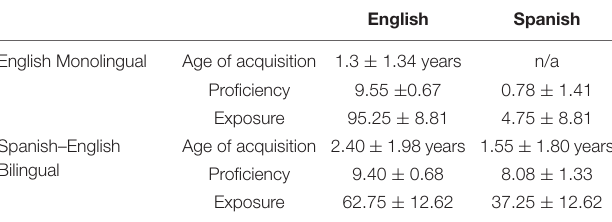
TABLE 1 | Language measures for English and Spanish in monolinguals and bilinguals.